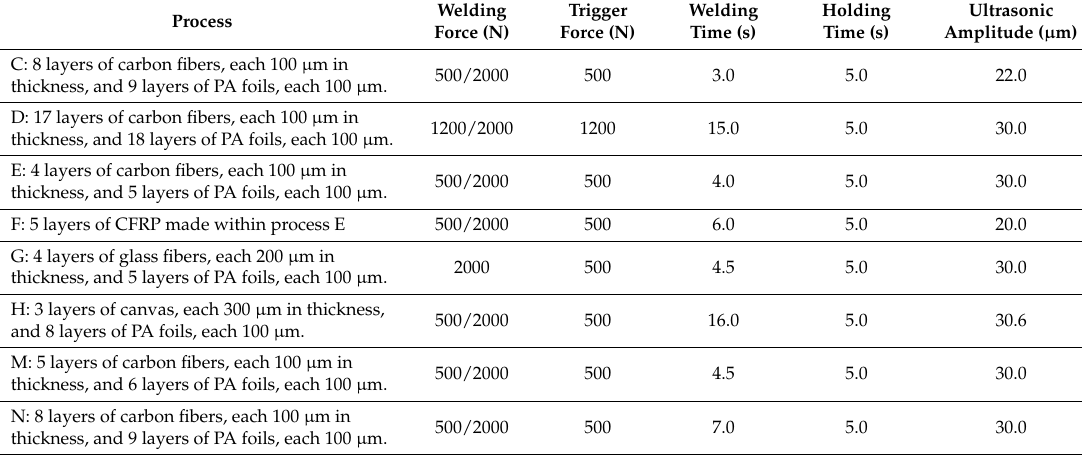
Table 3. Overview of the process conditions and the parameters for the ultrasonic fabrication of CFRP with the Herrmann Ultraschall HiQ DIALOG 6200 ultrasonic welding